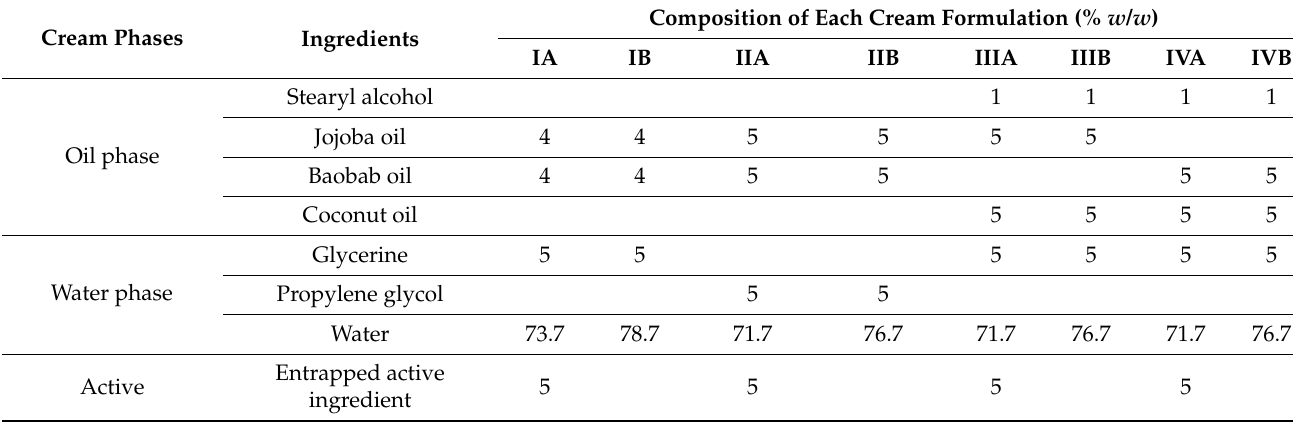
Table 1. Ingredients and % ( w / w ) composition of each cream